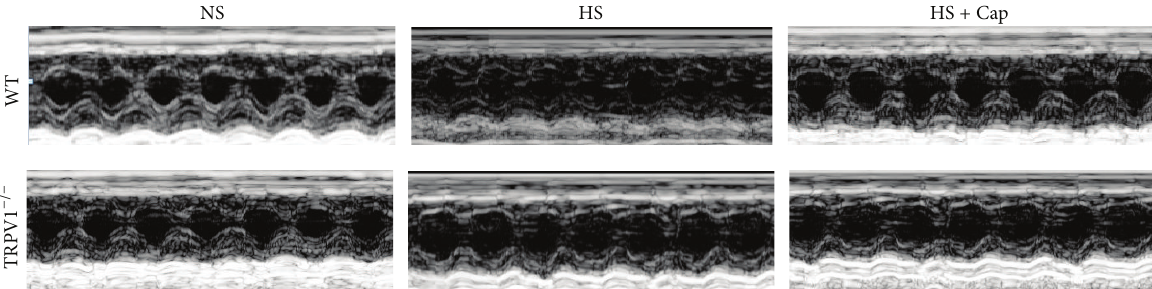
Figure 2: Representative echocardiography from wild-type (WT) and TRPV1-null (TRPV1 −/− ) mice on a normal diet (NS), a high-salt diet (HS), or a high-salt plus capsaicin diet (HS + Cap) for 1